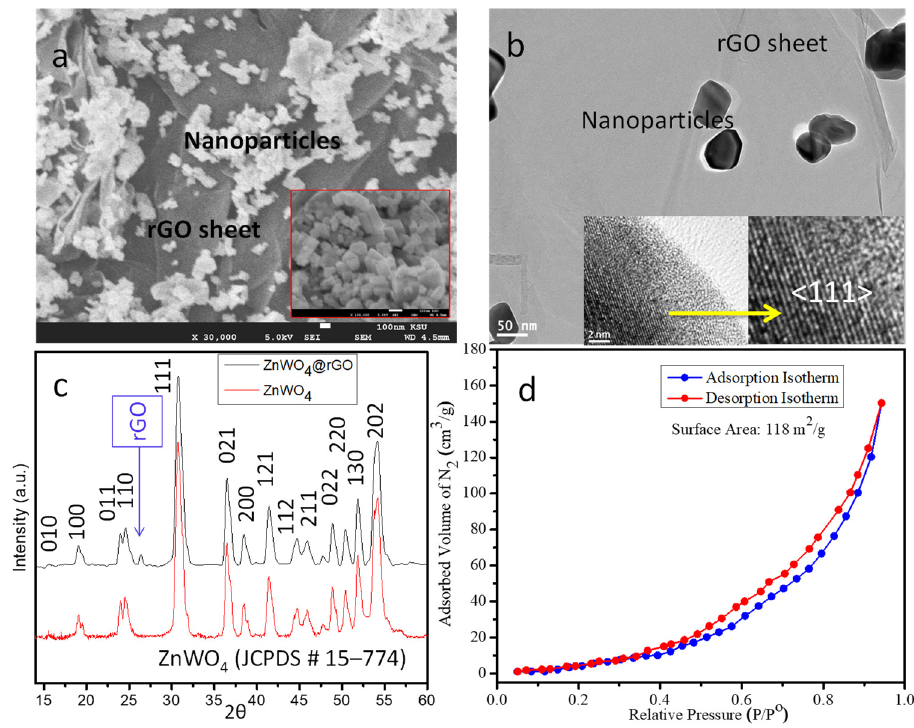
Figure 1. ( a ) FESEM (scale bar = 100 nm), ( b ) TEM, ( c ) XRD, and ( d ) N 2 adsorption–desorption isotherm of ZnWO 4 -NPs@rGO nanocomposites. The inset of ( a , b ) shows high magnification FESEM and HR-TEM images, respectively.